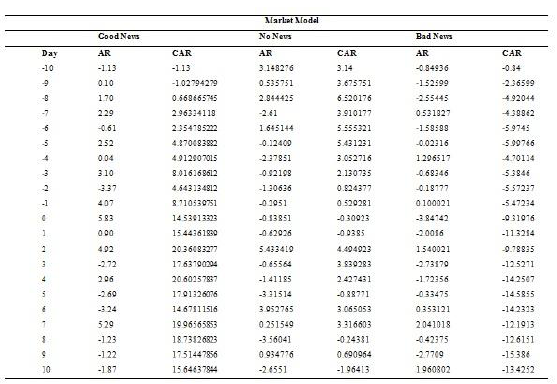
Table 3: AR and CAR values for Event Days -10 to +10